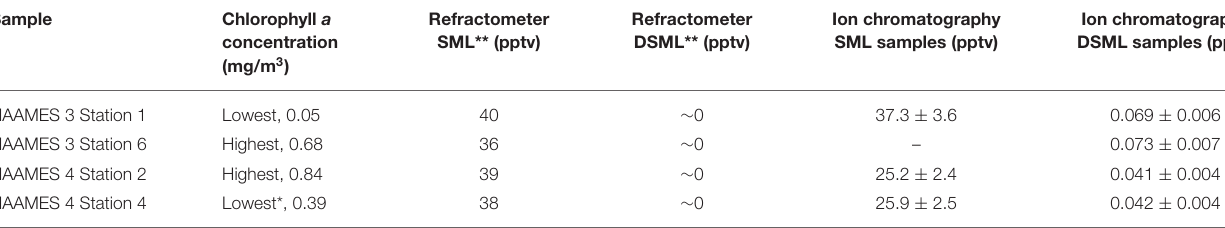
TABLE 2 | Salt concentrations of selected samples before and after desalting.